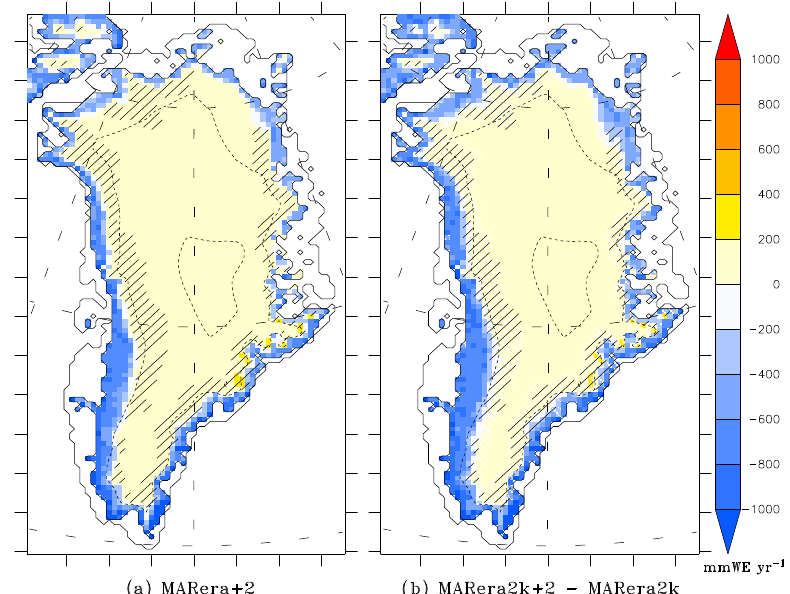
Figure 2. (a) Mean anomalies of annual SMB (mmw.e.y − 1 ) of MAR forced by an ERA-Interim warmer by + 2 ◦ C compared to MAR forced by unaltered ERA-Interim over 1980–1999. (b) Differences between mean anomalies of annual SMB (mmw.e.y − 1 ): MARera2k+2 minus MARera2k. Areas where anomaly differences are smaller than the inter-annual variability (i.e. the standard deviation) of the simulation of MAR forced by unaltered ERA-Interim over 1980–1999 are hatched. Dashed lines are equal altitude lines of 2000 and 3000m. See Appendix A and Tables A1 and A2 for abbreviations.